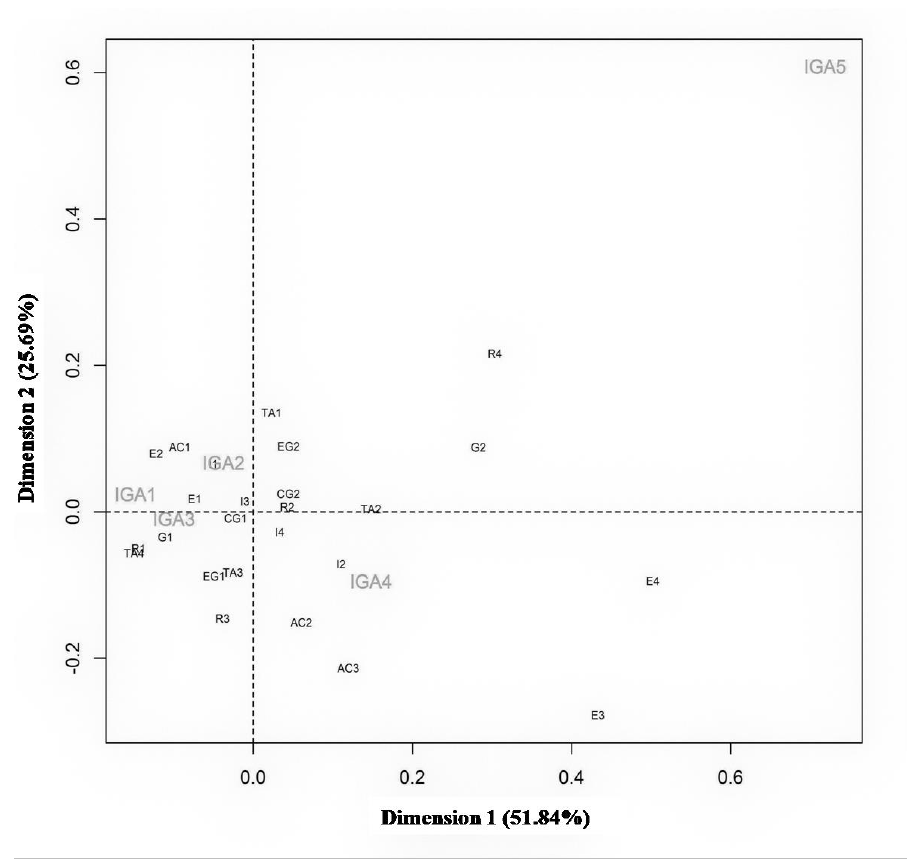
Figure 2. Correspondence map of the multiple choice item son teachers’ perception about genetic and environmental influence in Learning Difficulties and the sample groups. IGA1=only genes; IGA2=more genes than environment; IGA3=genes and environment in equal parts; IGA4=more environment than genes; IGA5=only environment. G1=Female; G2=Male; AC1=human sciences; AC2=biological sciences; AC3=exact sciences; EG1=studied genetics; EG2=did not study genetics; CG1=knows genetics; CG2=does not know genetics; E1=complete higher education; E2= complete higher education with specialization; E3=master’s degree; E4=doctorate and postdoctoral training; R1, R2, R3 and R4=income ranges